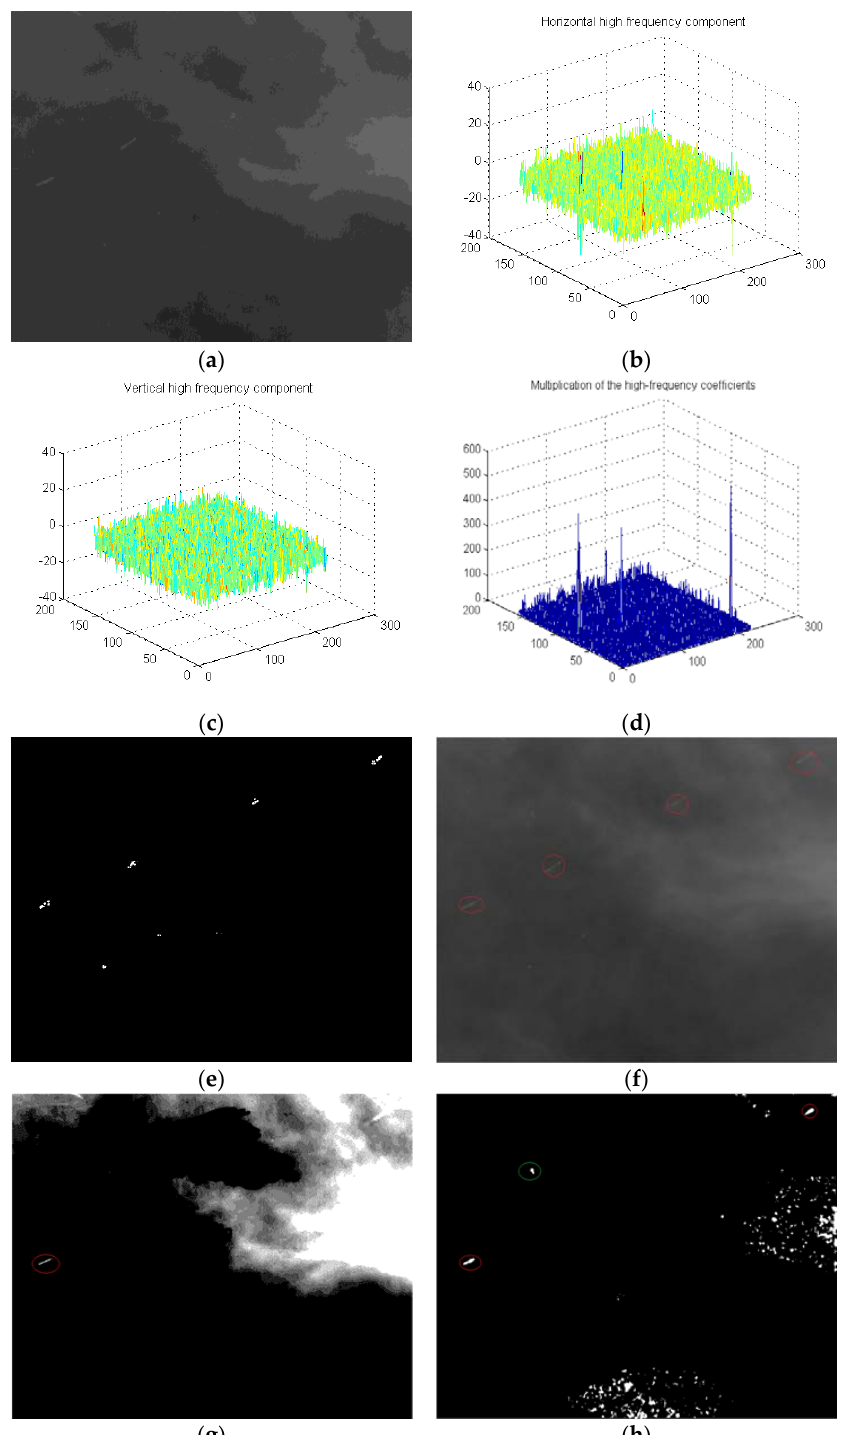
Figure 15. The ship detection results from the three different methods. ( a ) An image covered by thin clouds; ( b ) the three-dimensional map of horizontal transformation coefficients by EWT; ( c ) the three-dimensional map of vertical transformation coefficients by EWT; ( d ) the final results of the EWT; ( e ) a binary segmentation image of phase significant map; ( f ) the detection results from our proposed method; ( g ) the detection results by the method in Reference [18]; ( h ) the detection results by the method in Reference [17].